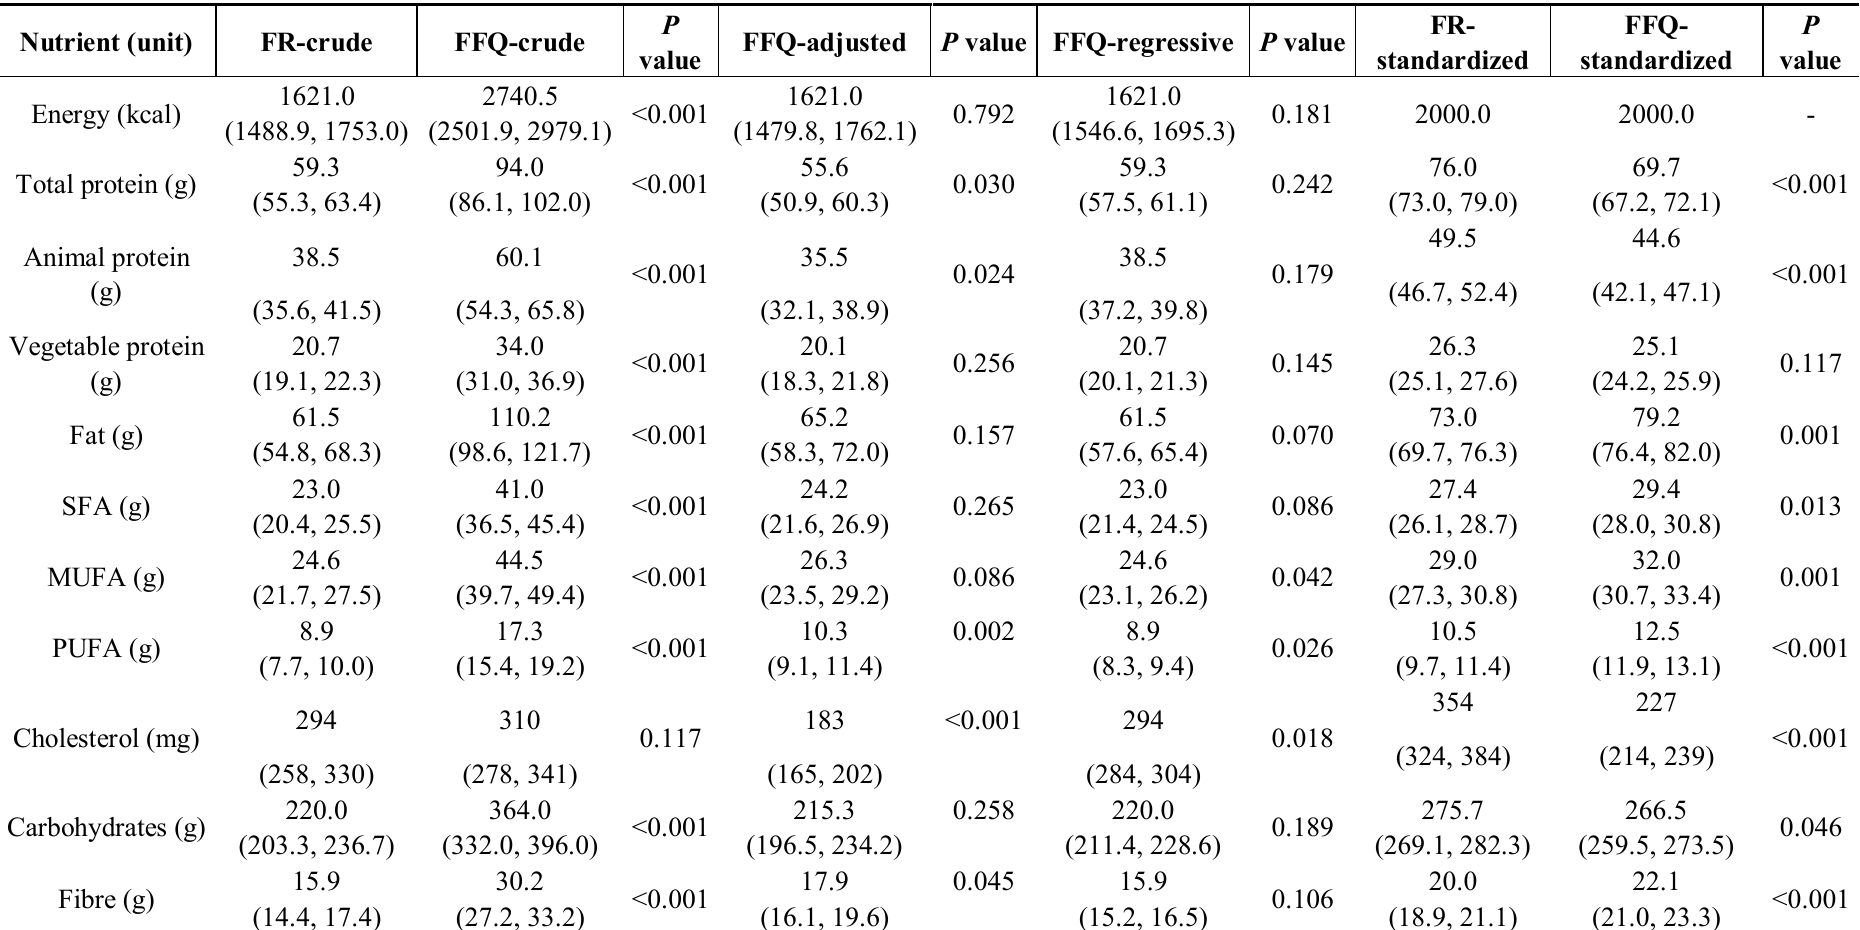
Table 2. Mean daily energy and nutrient intake by women ( n 84) in the three-day unweighted food record (FR) and the food frequency questionnaire